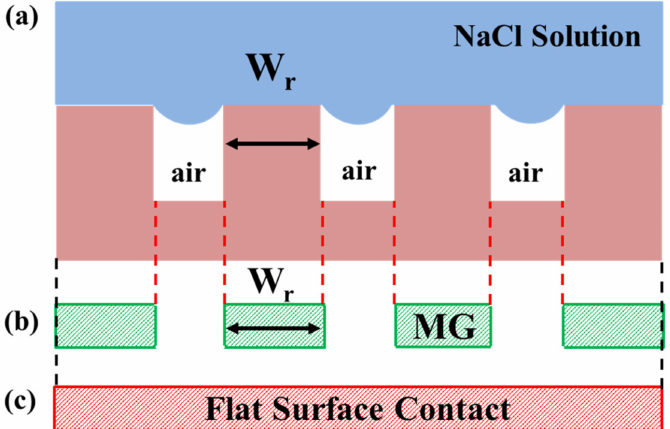
Figure 8. ( a ) Schematic showing wetting of MG with the corrosive fluid (NaCl solution), wherein the fluid wets the top of their ridges, with air trapped in their grooves (composite wetting, i.e., solid–liquid–air interface). ( b ) Area wetted by the fluid on MG (green shaded areas). ( c ) Area wetted by the fluid on the flat surface (red shaded